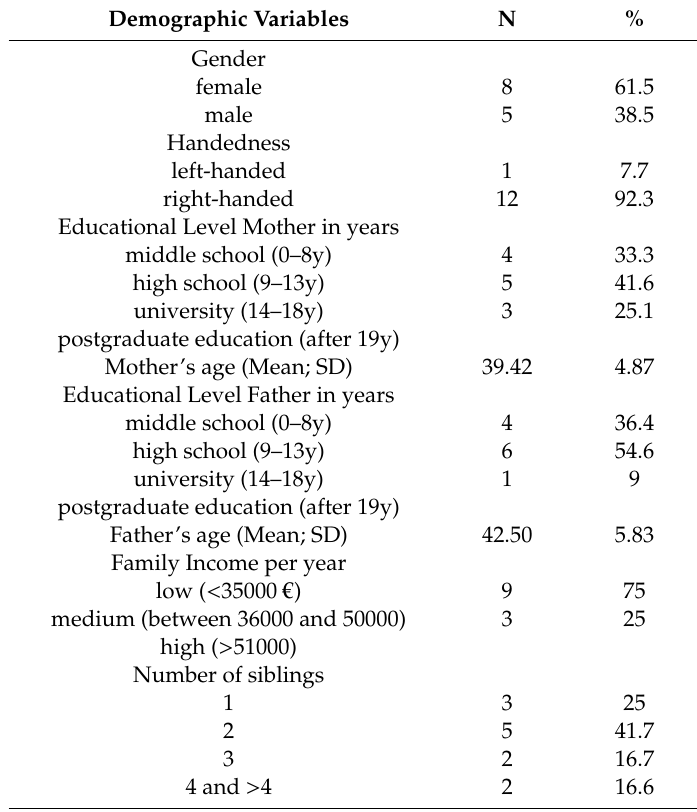
Table 1. Descriptive statistics of the study participants expressed in absolute values, percentages, means and standard deviations